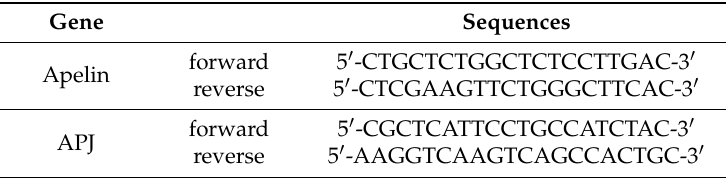
Table 1. Primer sequences used in the qRT-PCR